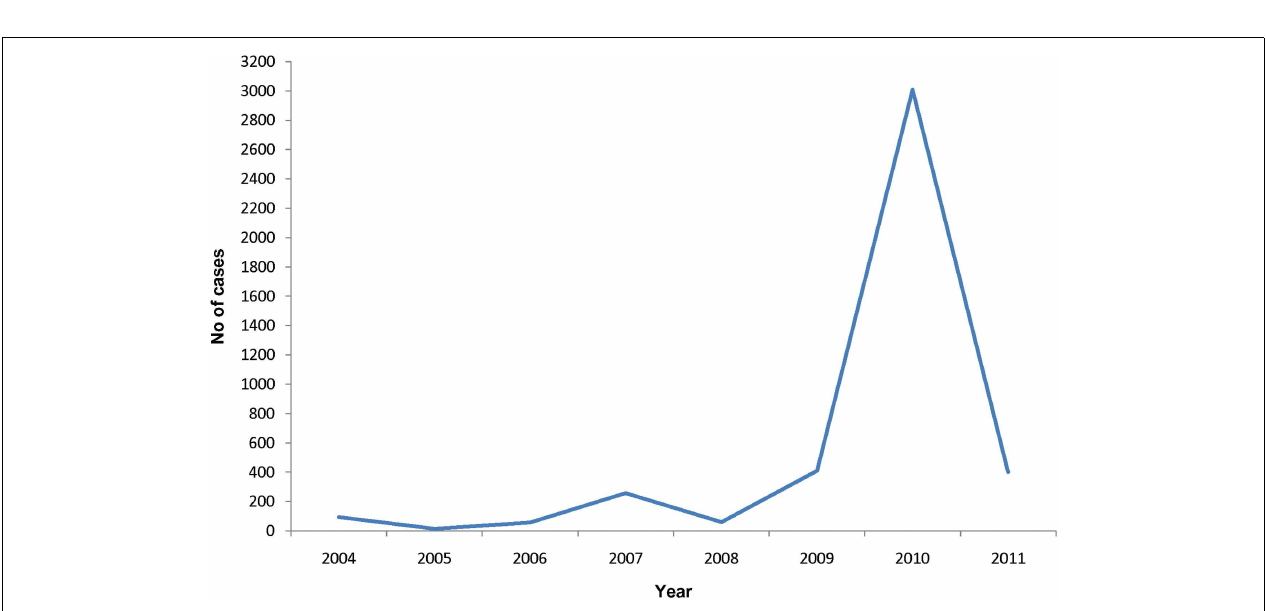
FIGURE 5 | Number of dengue cases in the period 2004–2011 in the Jaffna district of Sri Lanka. Data from the Office of the Regional Director of Health,